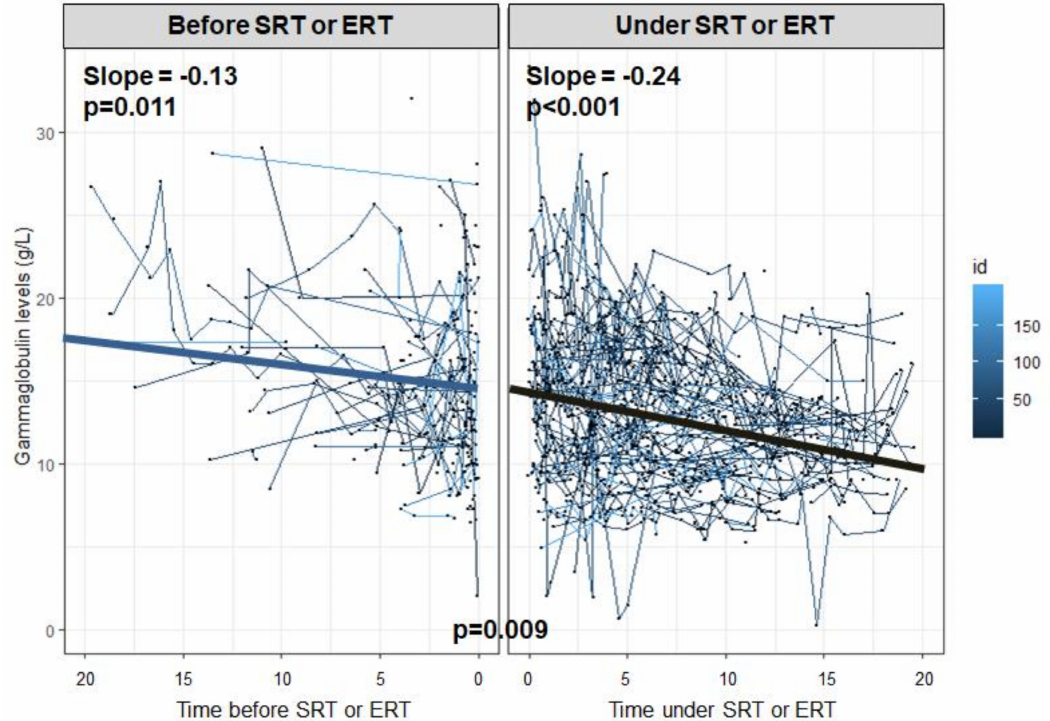
Figure 2. Evolution of gammaglobulin level before and after GD treatment. Treatment included enzyme replacement therapy or substrate reduction therapy. Slopes were obtained with linear / logarithmic mixed models on patients who received treatment, at two periods: before and after starting treatment. The impact of the treatment was assessed by using an interaction term between period and